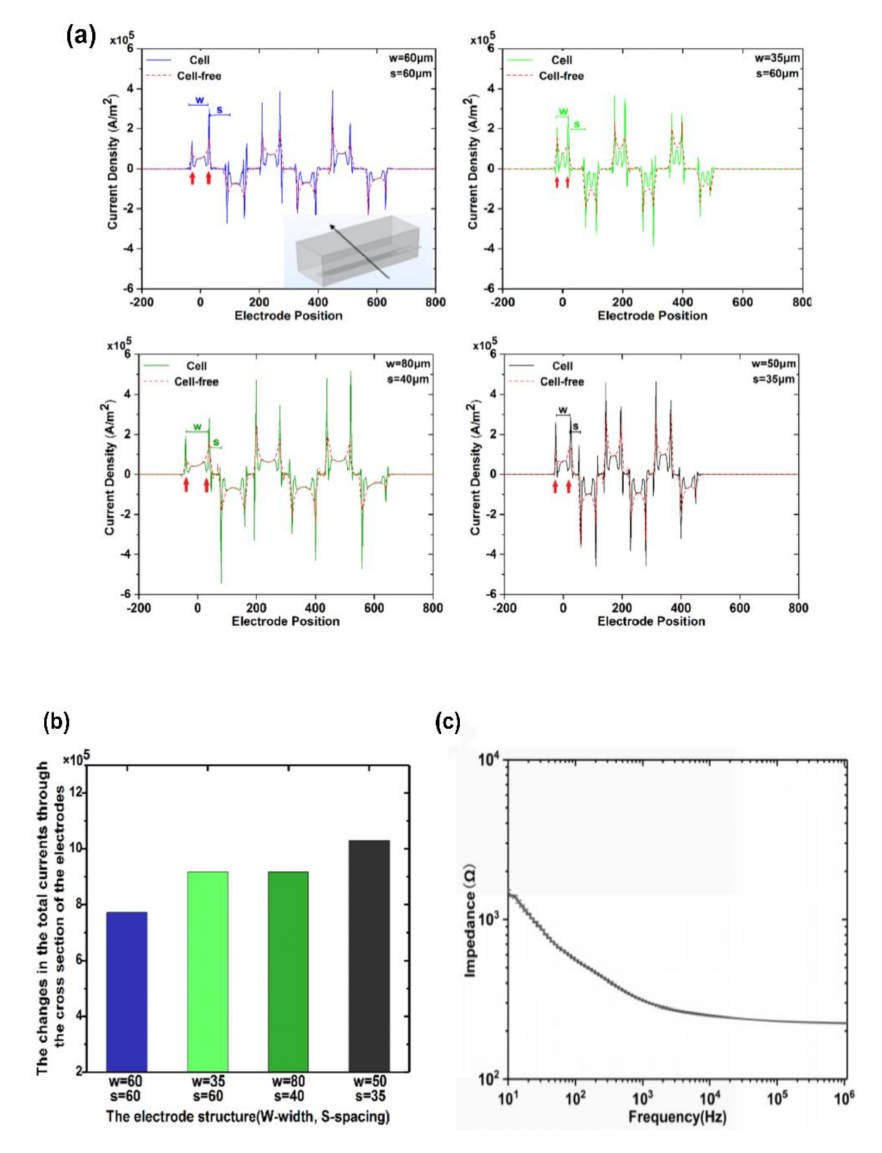
Figure 4. ( a ) Changes in current density passing through the cross section of the electrodes with different dimensions. ( b ) The differences of the total currents through the cross section of the electrodes before and after addition of cells on the top of the electrodes. ( c ) The experimental absolute impedance |Z| value of the selected electrodes, with DMEM as a function of frequency. Changes in the impedance response of cells could be associated with the sensitivity of the electrodes, the type of cells, and biological processes that cells undergo. It was